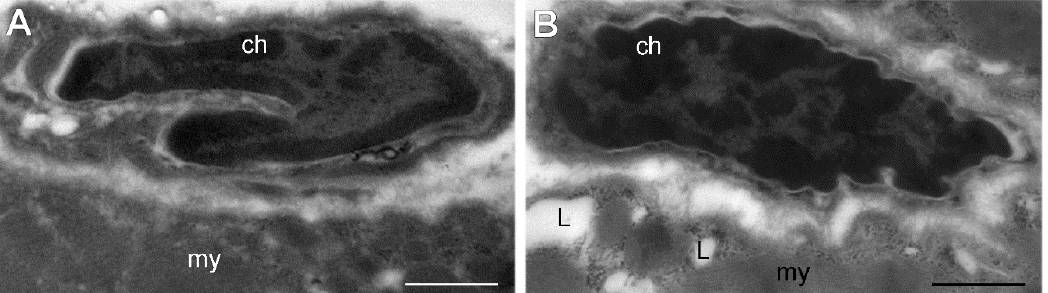
Figure 1. Transmission electron micrographs of satellite cells (SCs) bordering a myofiber (my) in skeletal muscles from euthermic ( A ) and hibernating ( B ) dormice. In both seasonal phases, SC nuclei contain large amounts of heterochromatin (ch). ( B ) The accumulation of lipid droplets (L) in the myofiber is a typical feature of hibernating edible dormice [28]. Bars: 1 μ m. In the LR White embedded samples, the usual RNP structural constituents involved in pre- mRNA transcription and processing were evident in the nucleoplasm (Figure 2): a few perichromatin fibrils (PFs; representing the in situ form of nascent transcripts, as well as of their splicing and 3 ′ end